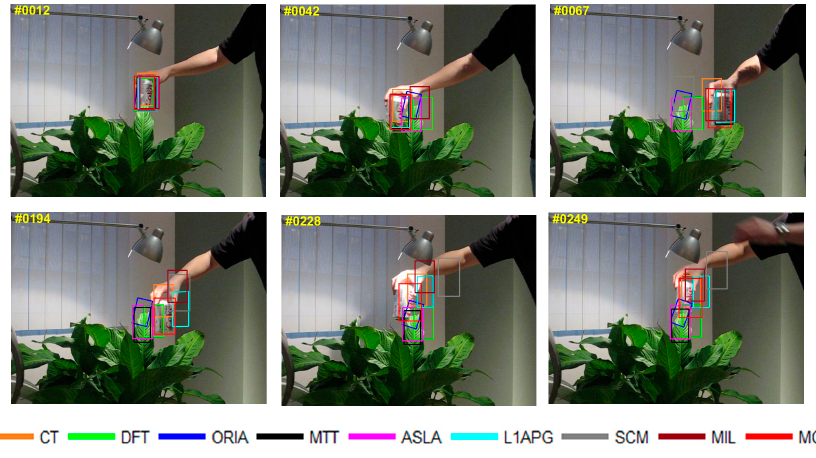
Figure 10. Tracking results on Coke .